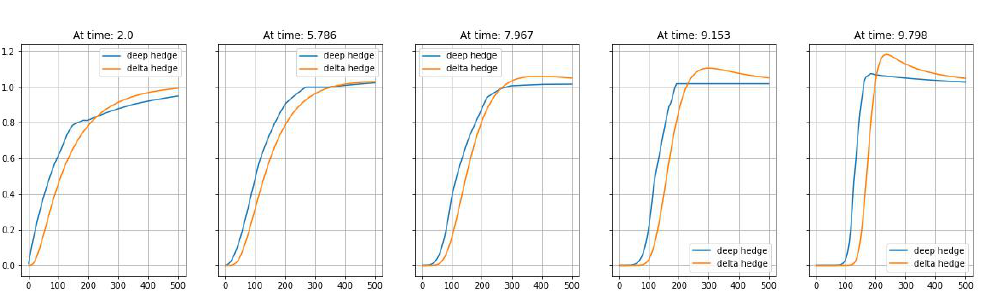
Figure 5. Terminal wealth ( p = 2).